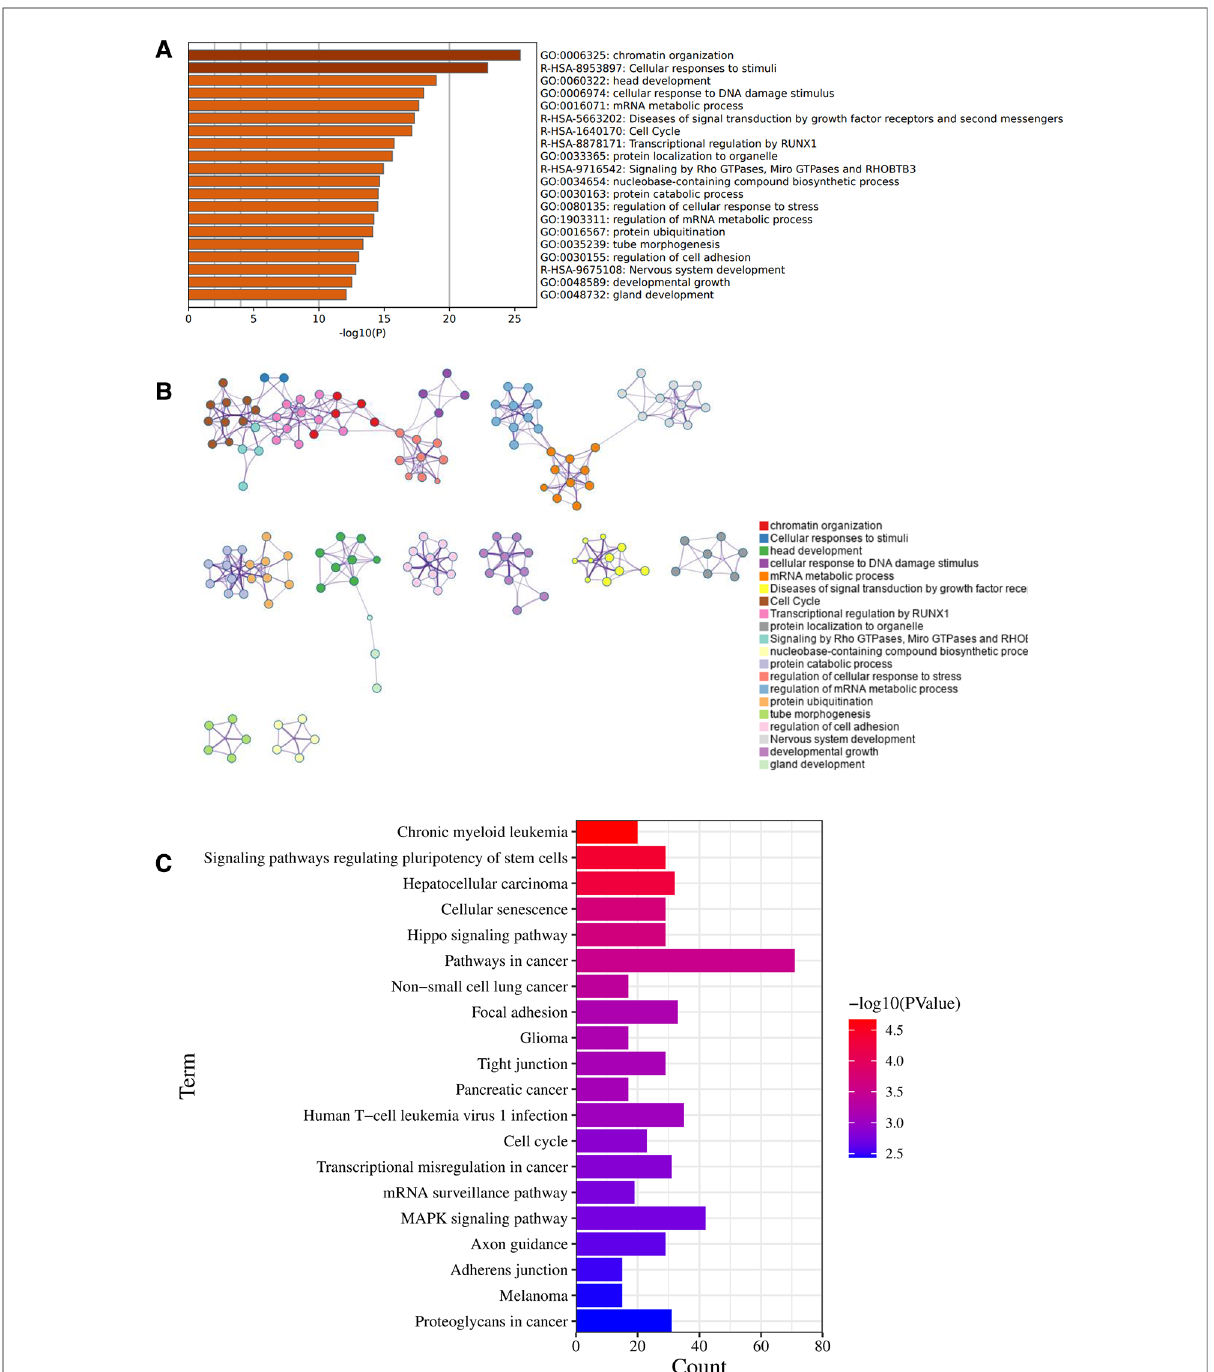
FIGURE 2 Enrichment pathway and analysis of microRNA-320a-targeted genes. ( A ) Bar graph of 20 enriched terms were colored by p -values, and p -value< 0.01 was statistically signi fi cant. ( B ) Network of enriched terms colored by cluster ID, where nodes sharing the same cluster ID are usually close to each other. ( C ) The top 20 remarkably enriched signaling pathway were analysis by KEGG